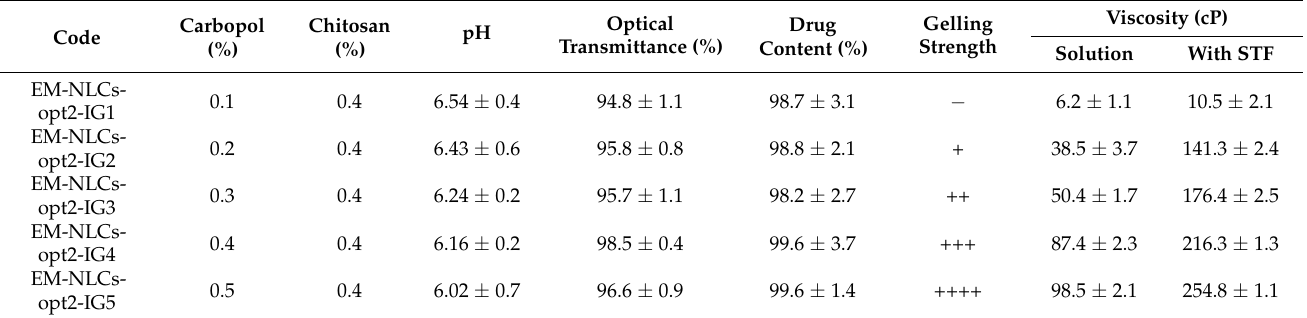
Table 5. Physicochemical parameter evaluation of EM-NLCs in situ gel system. The study performed in triplicate and data shown as mean ±